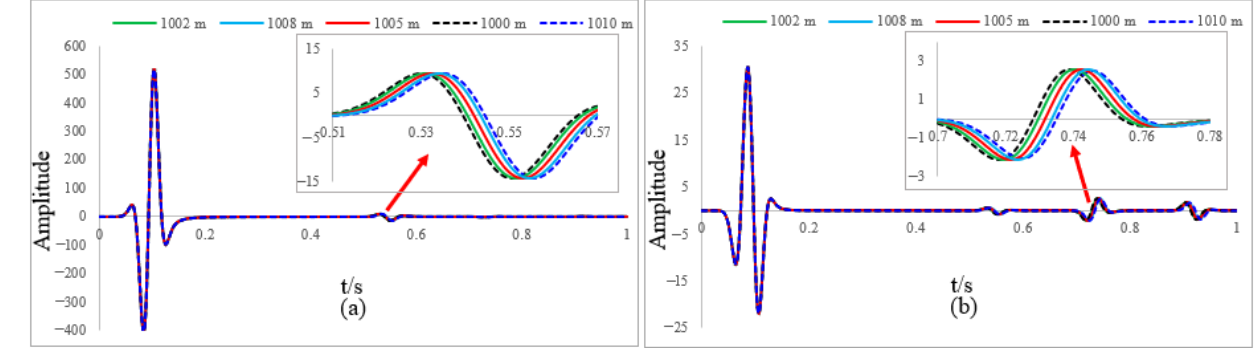
Figure 9. Seismic records at different interface depths: ( a ) X component; ( b ) Z component.